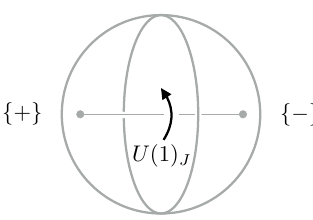
Figure 7. We consider a U(1)